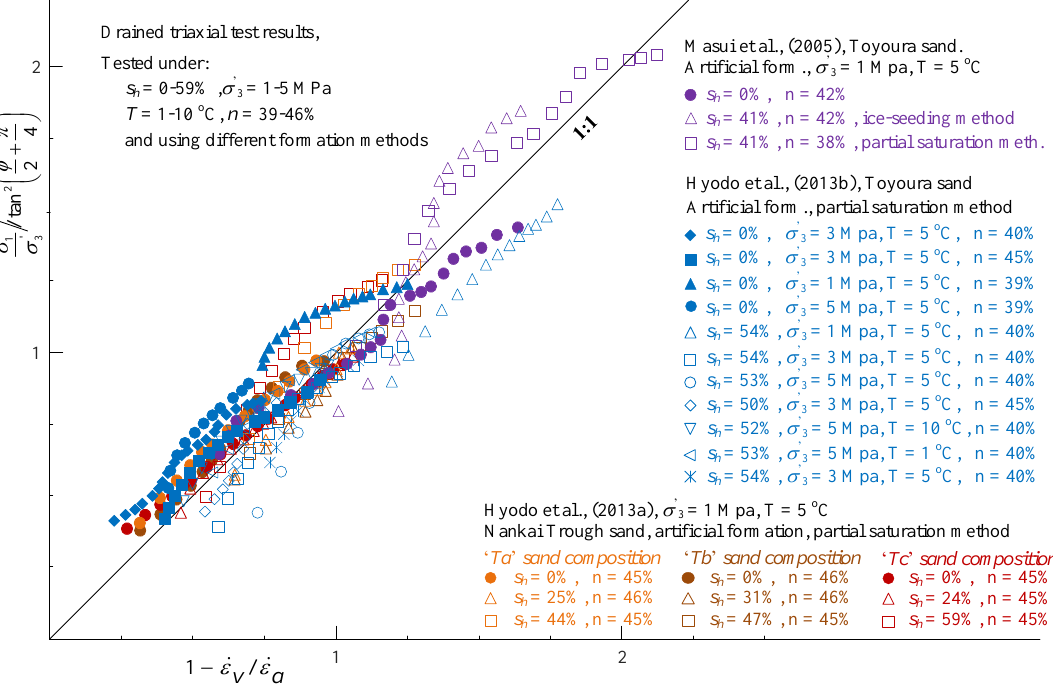
Figure 3. Results of drained triaxial tests of water-saturated methane-hydrate-bearing sediments (MHBS) of Masui et al. [20], Hyodo et al. [25], and Hyodo et al. [37], plotted on the 1 − ˙ (cid:101) v / ˙ (cid:101) a and σ (cid:48) / σ (cid:48) axes, for different s h values, hydrate morphologies, sample porosities, temperatures, 3 1